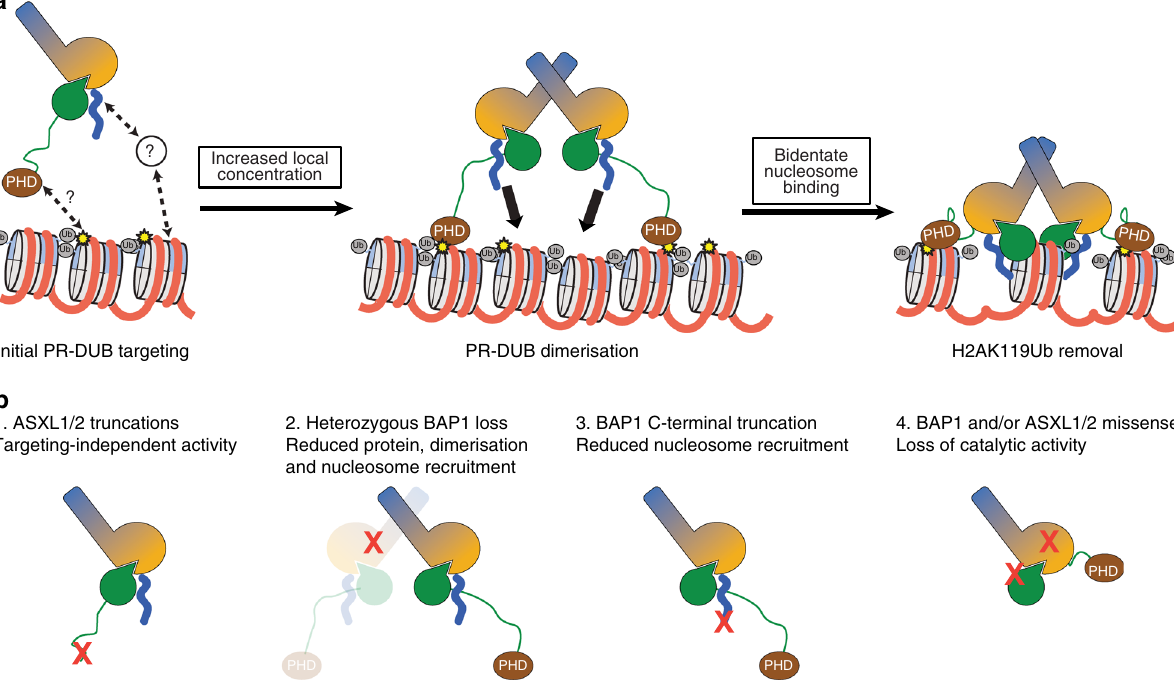
Fig. 7 Model for PR-DUB regulation and its disruption in human cancers. a The 1:1 PR-DUB complex is fi rst targeted to nucleosomal arrays either via the PHD domain of ASX-like proteins or through interactions with transcription factors and/or other binding partners (left). Enrichment of multiple 1:1 complexes in speci fi c genomic regions increases the local PR-DUB concentration, favouring Calypso/BAP1 dimerisation and formation of a bidentate PR- DUB complex (middle). With bidentate complex formation, two C-terminal positively charged tails of Calypso/BAP1 are optimally oriented, enhancing nucleosome recruitment and ef fi cient removal of H2AK119Ub (right). b Distinct classes of human PR-DUB mutations can impair PR-DUB